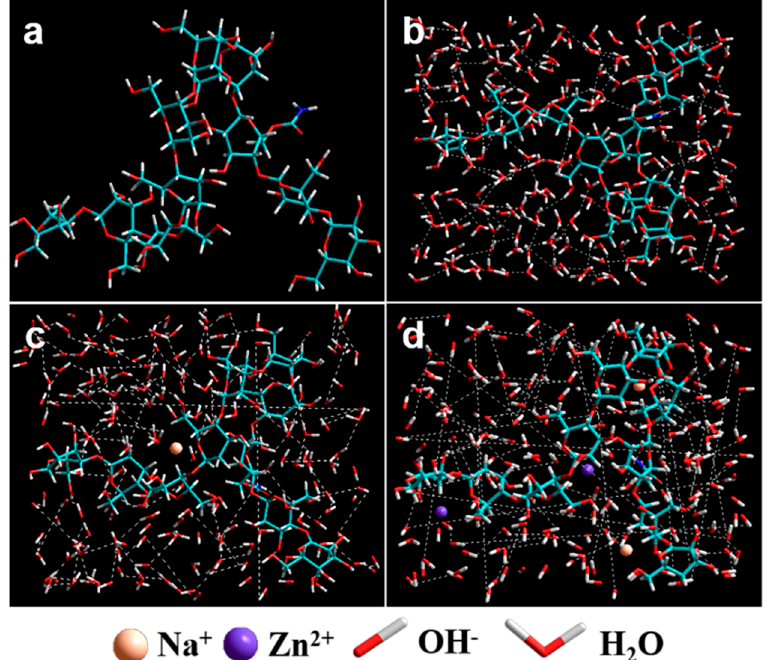
Figure 9. The molecular simulation of ( a ) CC chains, CC in ( b ) H 2 O, ( c ) NaOH/H 2 O, and ( d ) NaOH/ZnO/H 2 O.